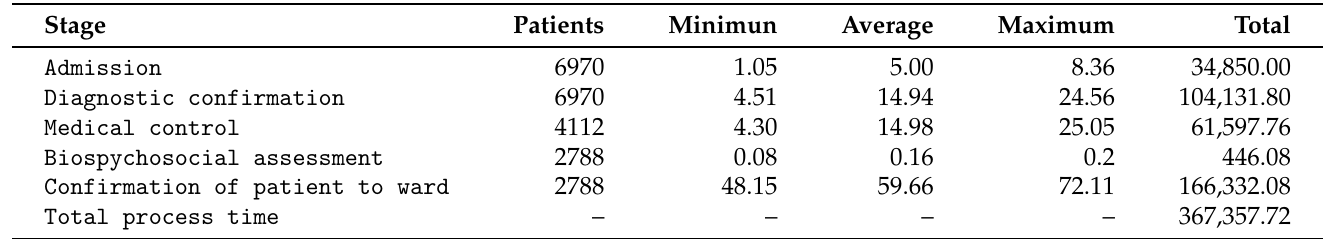
Table 7. Simulation of the network prioritization process for new patients in SWL, measured in minutes, according to the new SB